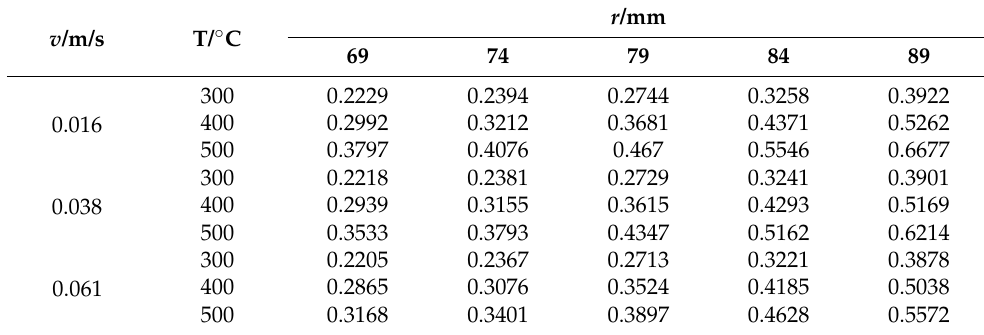
Table 3. The sectional radial deformation of point B when all threads are screwed (mm).